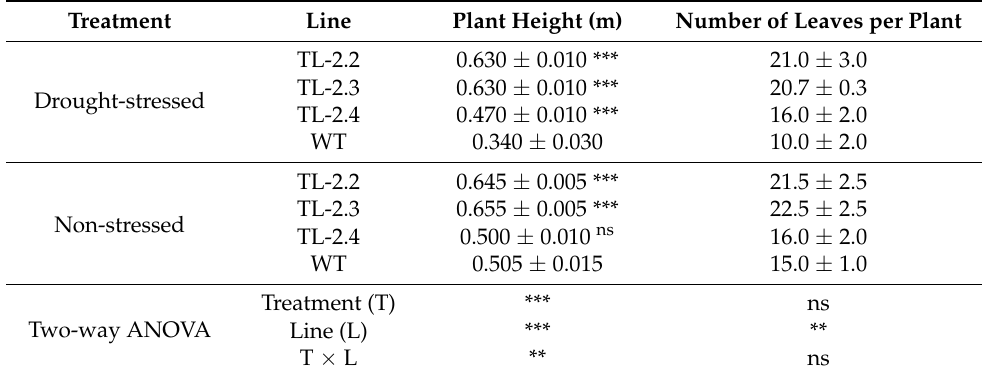
Table 5. Plant height and number of leaves per plant of different generations of transgenic faba bean line TL-2 and wild-type (WT) after 14 days of drought stress. Asterisks indicate significant difference within treatment by Dunnett’s test using WT as control upon significant interaction indicated by two-way ANOVA. *** p < 0.001, ** p < 0.01, ns insignificance with p > 0.05.